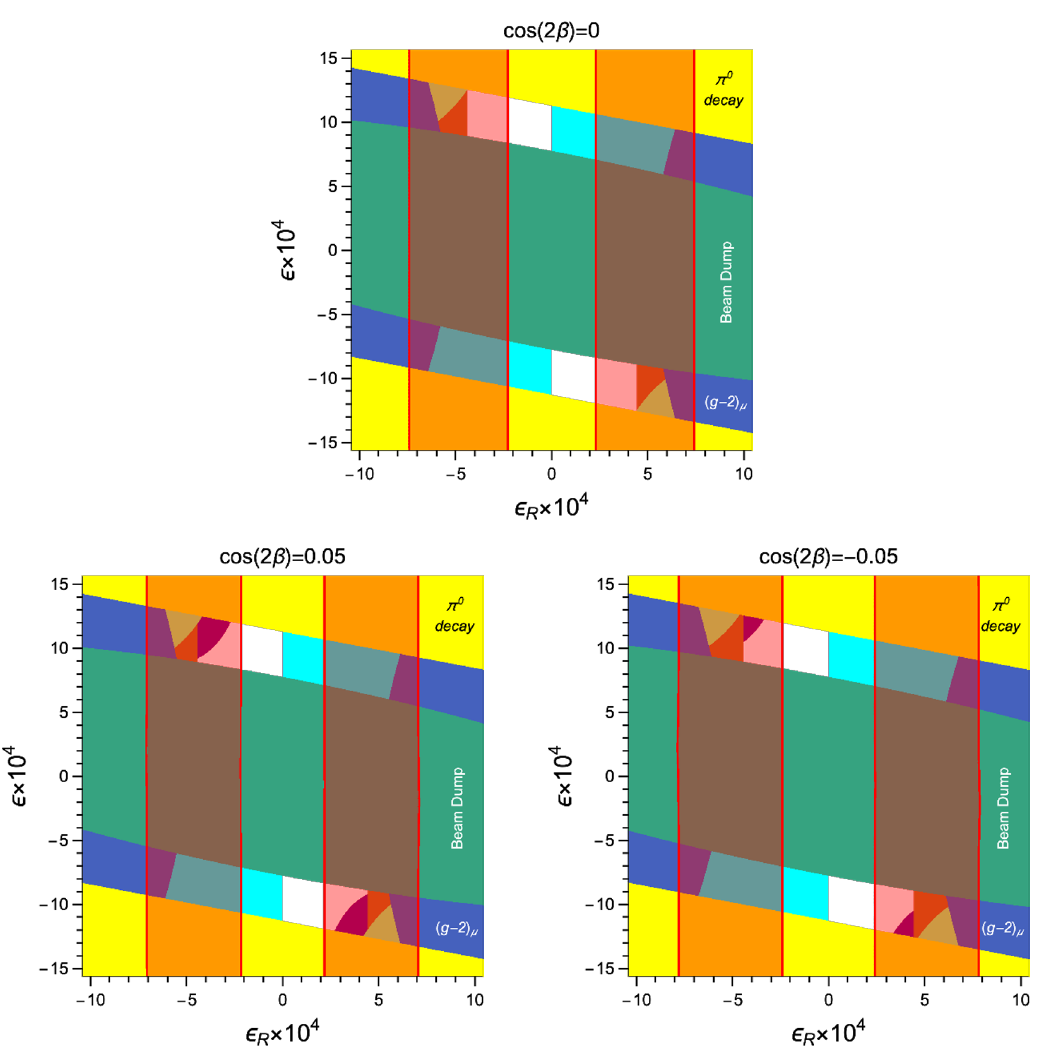
Figure 3 . Allowed parameter region and signal in Model 1. The red band is the signal region for the Atomki results. White region is allowed by experiments, while other colored regions are excluded by the constraints from rare π 0 decay (yellow), ν - e scattering (purple), ( g − 2) µ (dark blue), effective weak charge (light blue), electron beam dump (green), and VEV of S